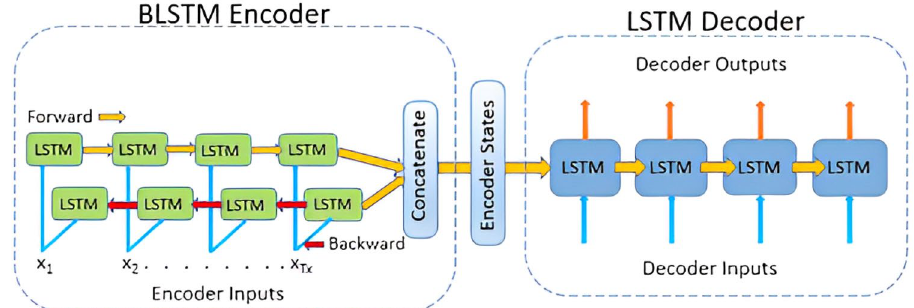
Figure 3. BiLSTM representation.